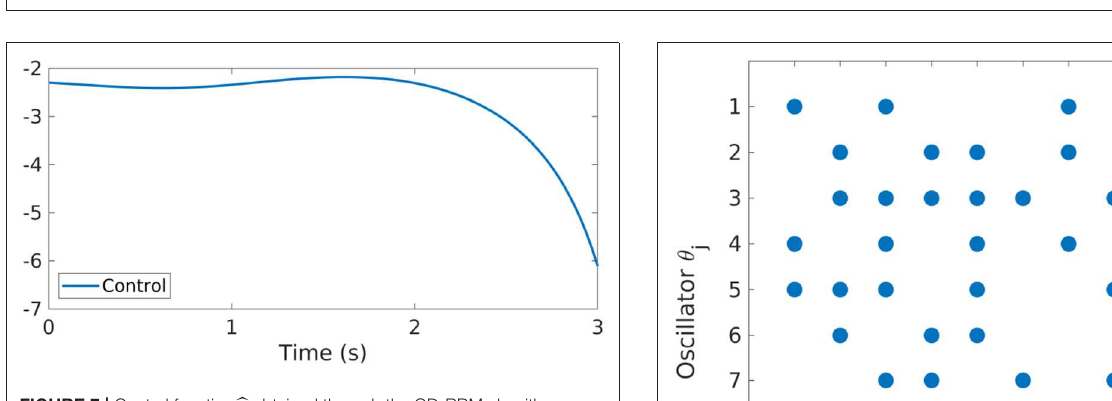
FIGURE 7 | Control function applied to the Kuramoto model [Equation (5)] with N K < 0.